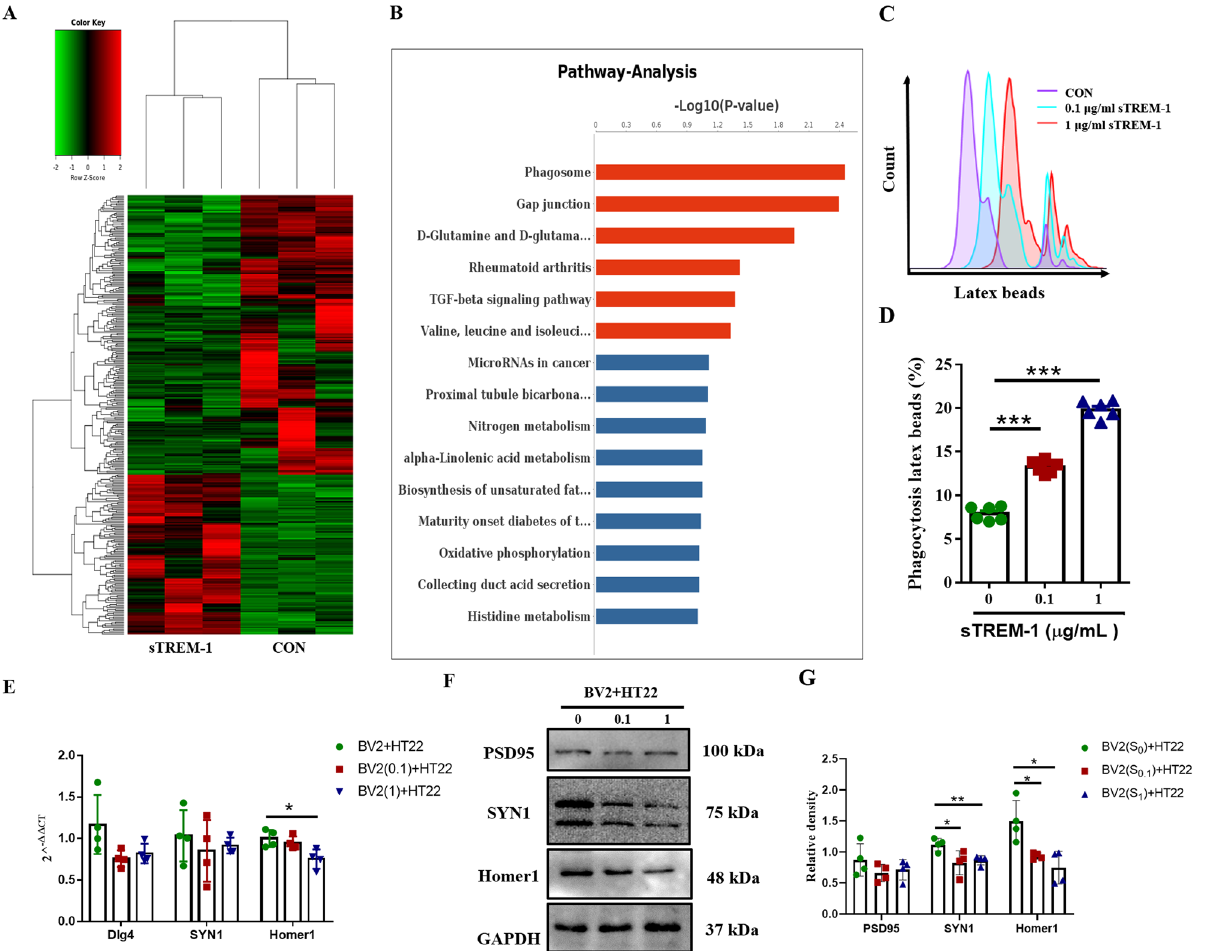
Figure 5. sTREM-1 enhances the phagocytosis of BV2 cells. (A) A heat map of all RNAs detected in the BV2 cells treated with or without sTREM-1 by transcriptomics sequencing. Red indicates upregulation; green indicates downregulation. (B) Pathway-Analysis diagram of BV2 cells in CON group and sTREM-1 treatment group. (C) Representative histograms of BV2 cells phagocytosis of latex beads were detected by flow cytometry in different treatment groups. (D) After BV2 cells were treated with sTREM-1, a phagocytic function test was performed, and the phagocytosis of BV2 cells was analyzed using flow cytometry. (E) The mRNA expression levels of Dlg4 , SYN1 , and Homer1 in different HT22 cell groups by Q-PCR. (F) Representative western blot images of PSD95, SYN1, and Homer1 protein expression in different HT22 cell groups. (G)